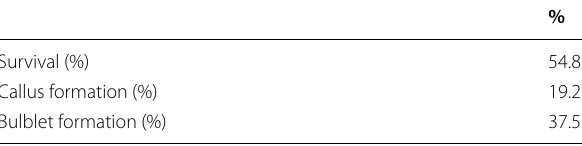
Table 2 Further development of in vitro seedlings